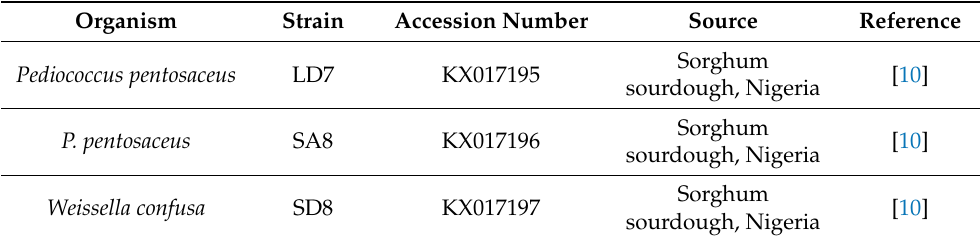
Table 1. Lactic acid bacteria used as starter cultures for sourdough production.